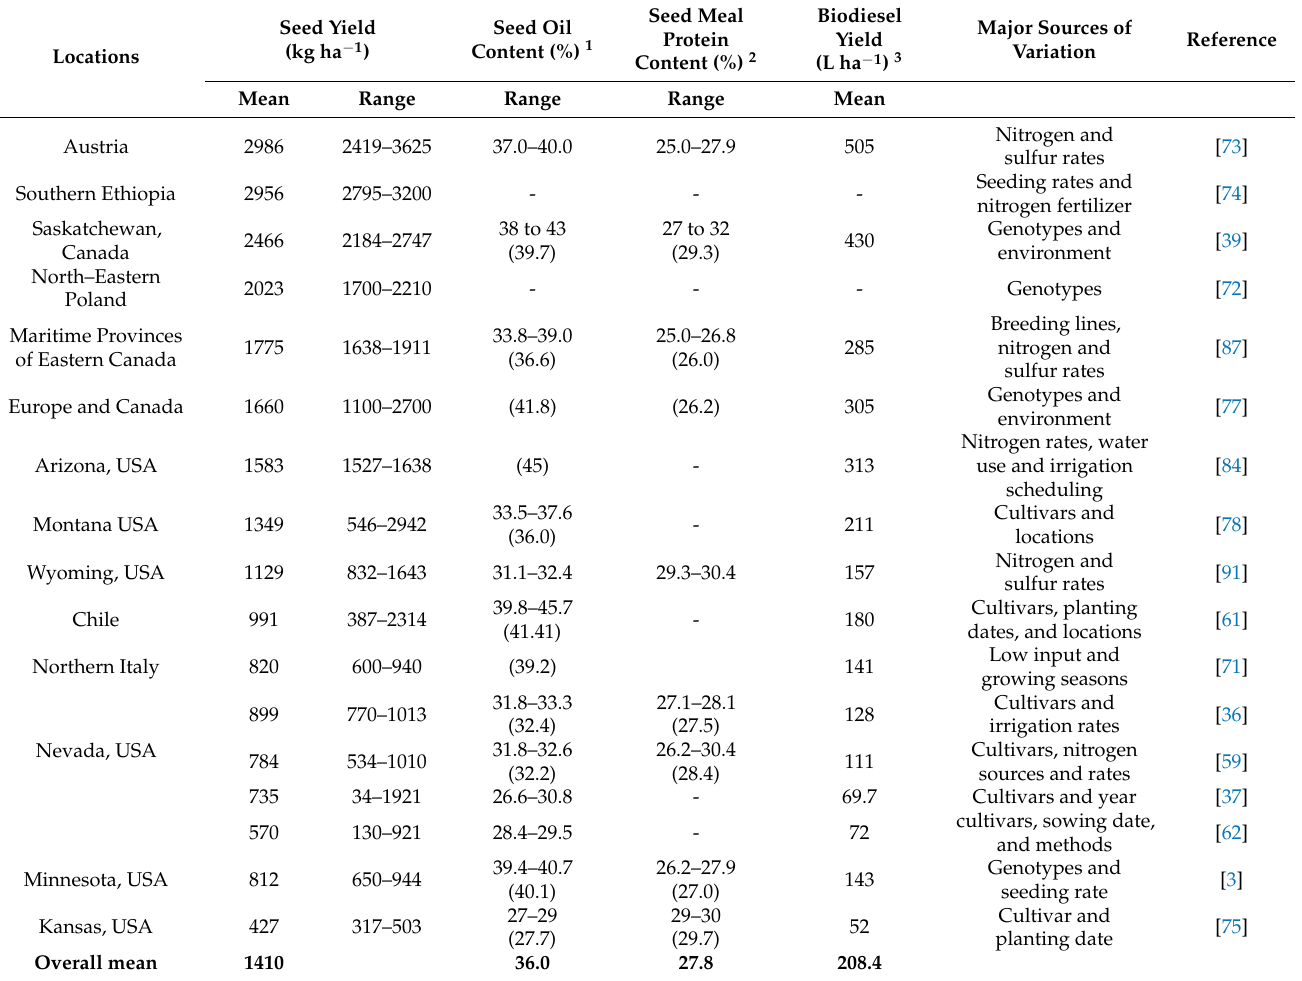
Table 1. C. sativa seed yield, oil, and protein content reported across various regions of the